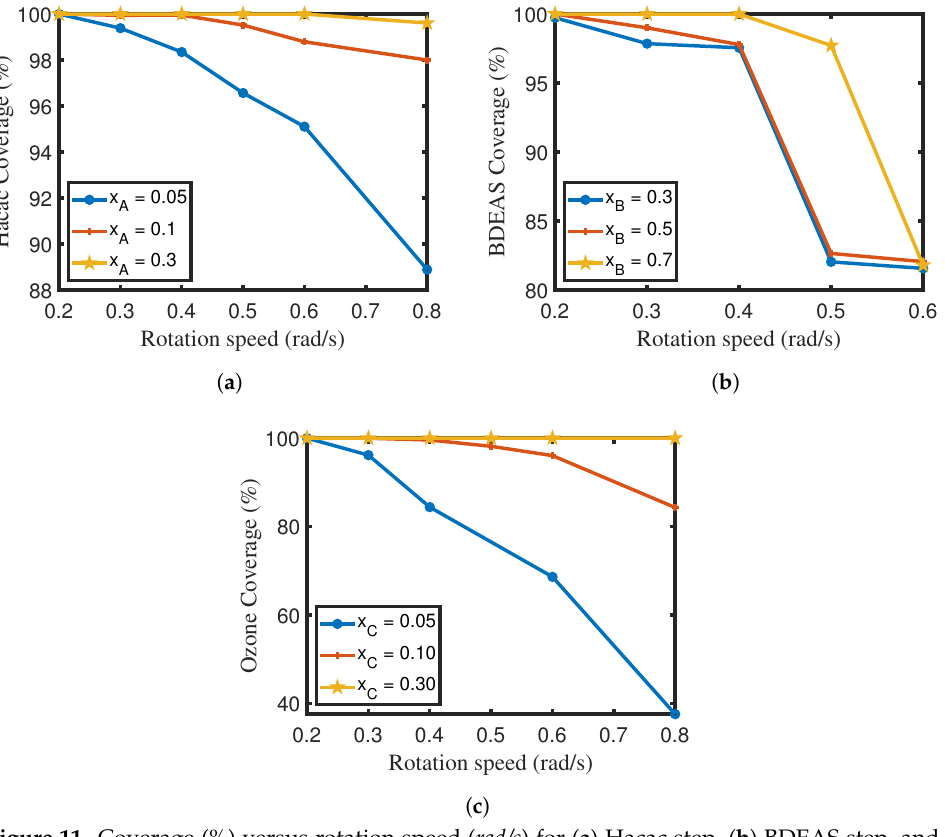
Figure 11. Coverage (%) versus rotation speed ( rad/s ) for ( a ) Hacac step, ( b ) BDEAS step, and ( c ) ozone step. x A , x B , and x C represents the mole fraction of Hacac, BDEAS, and ozone,